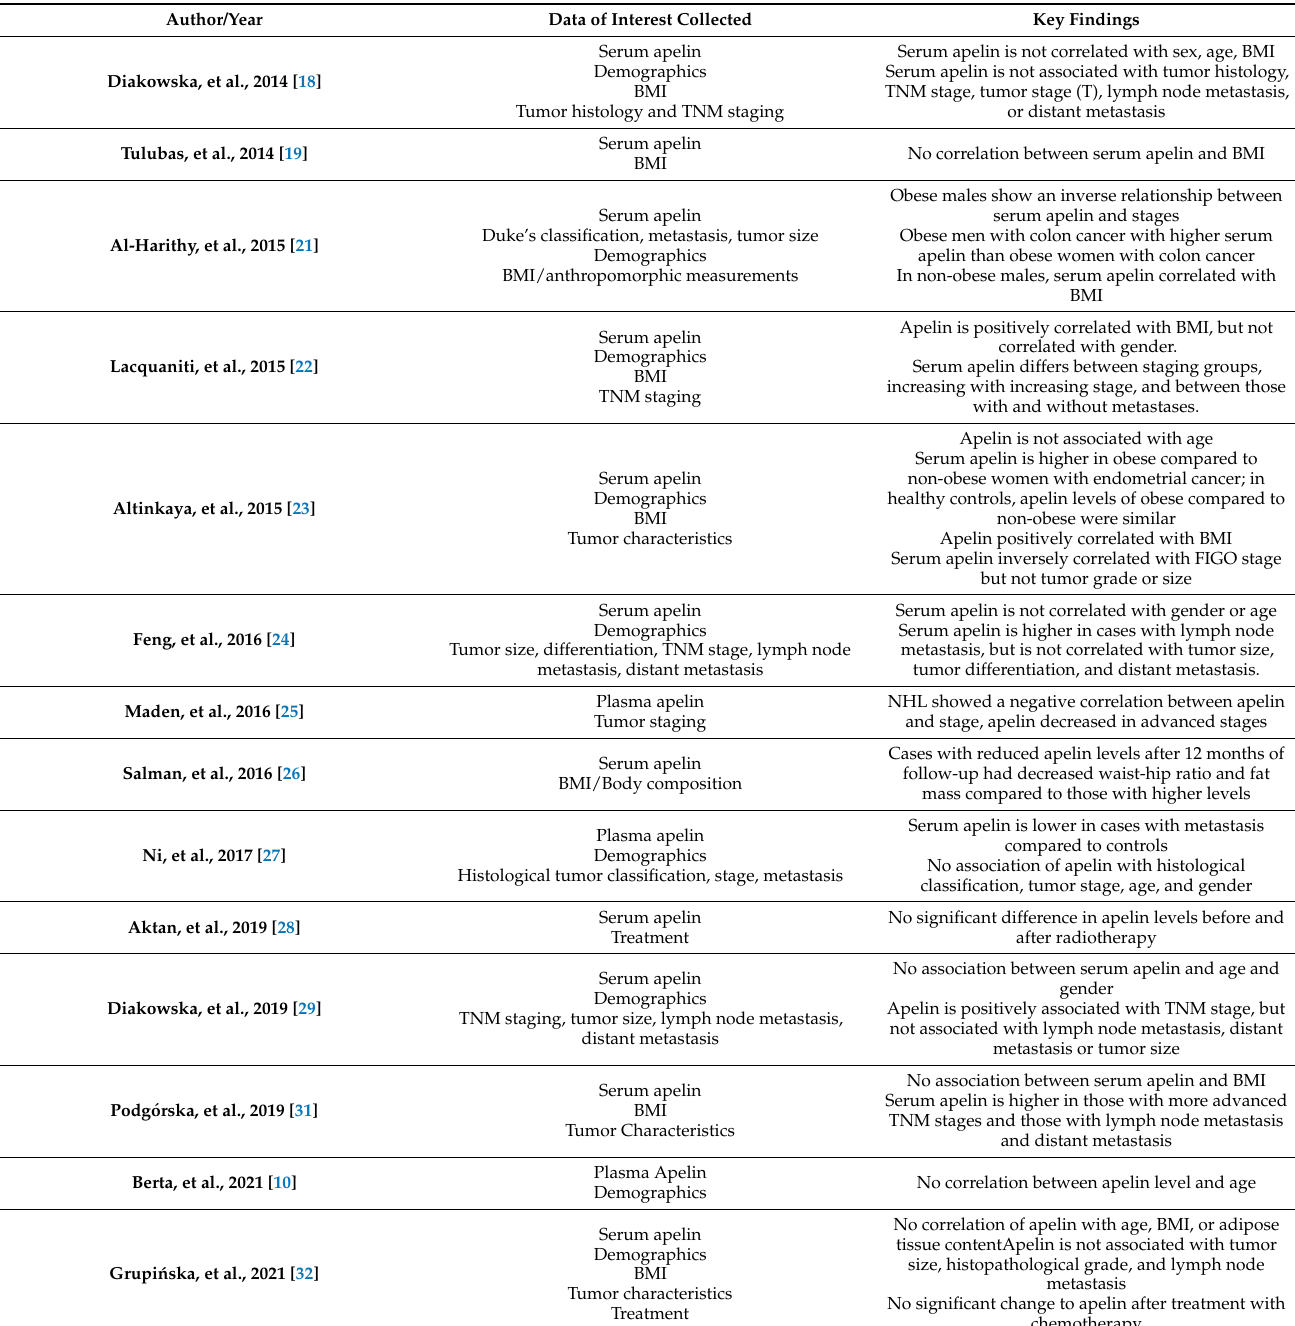
Table 3. Summary of Relationships Between Demographic and Clinical Characteristics and